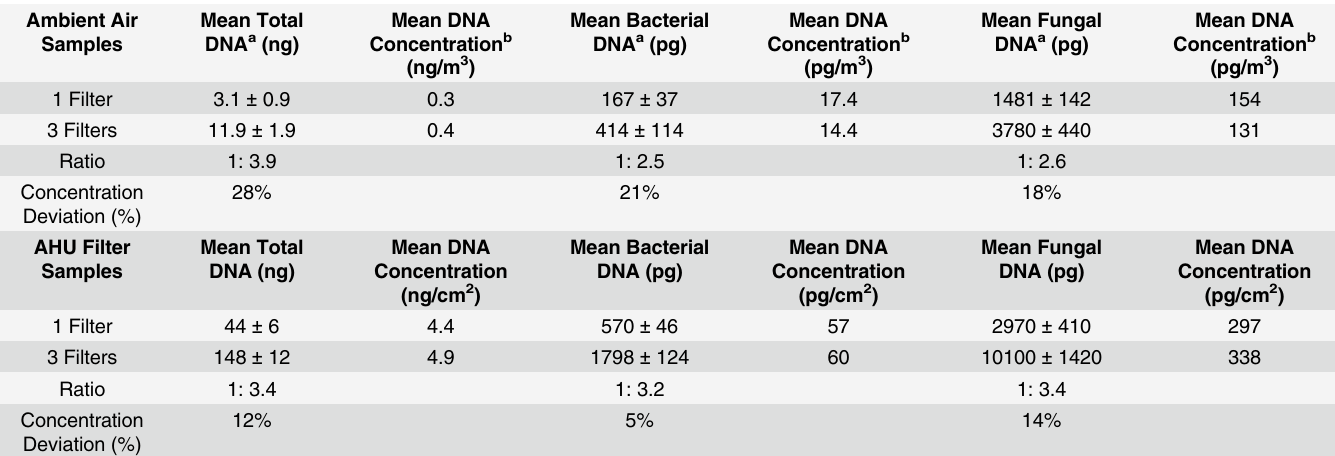
Table 3. qPCR cycle threshold value data for mid-concentration approach considering both 16S bacterial and 18S fungal probe-and-primer sets. Ambient Air